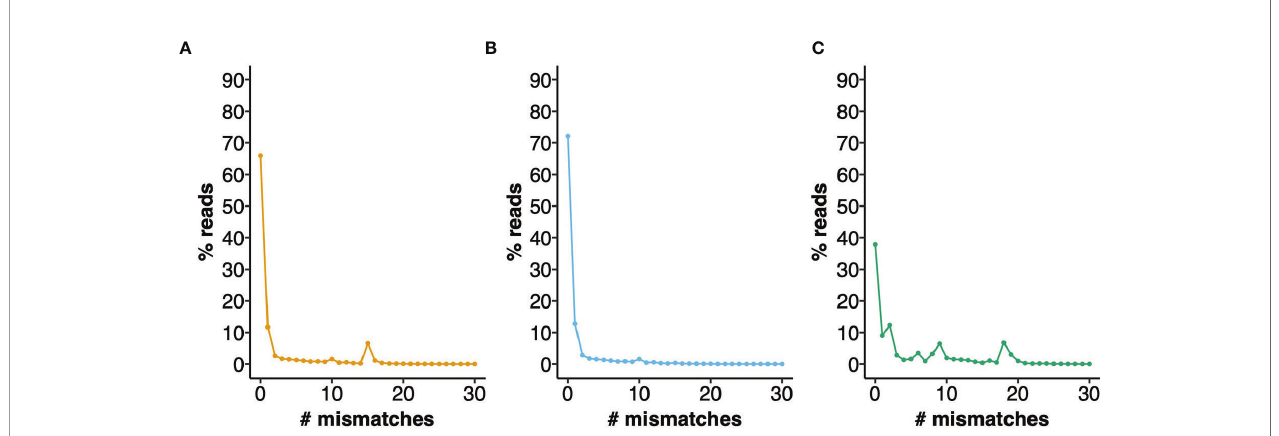
FIGURE 3 | Performance of different IGHV reference sets for the alignment of BALB/c VDJ sequences. IgM reads from BALB/c mice were aligned against different reference directories and the number of mismatches to the closest germline gene was calculated. The percentage of reads with 0 - 30 mismatches are plotted. (A) Aligned to OGRDB Reference set without the inclusion of musIGHV398 (B) Aligned to OGRDB Reference set with the inclusion of musIGHV398 (C) Aligned to IMGT Reference